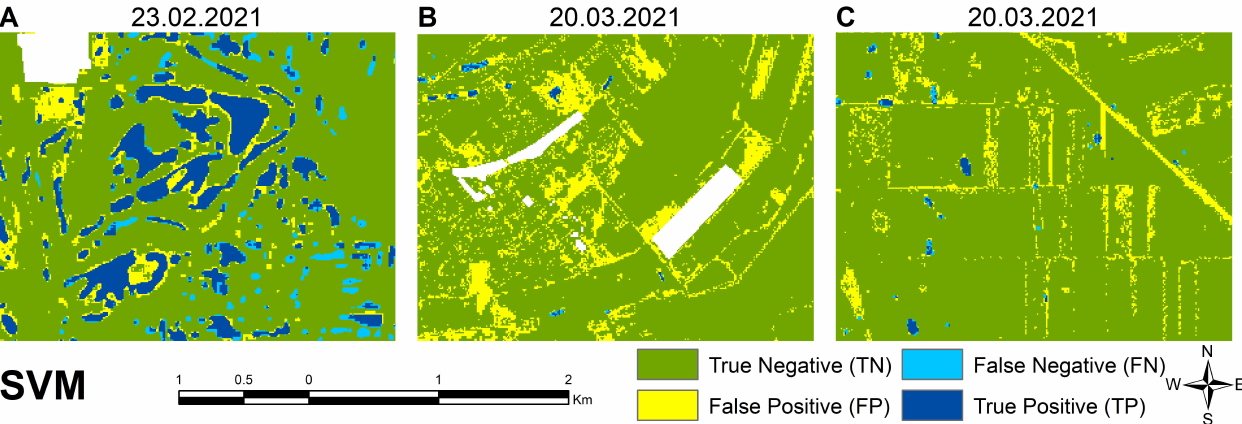
Figure 14. Examples of support ‐ vector machine model classification errors at different times, in ‐ cluding ( A ): Relatively small omissions 23 February 2021; ( B ): extreme overclassification 20 March 2021; ( C ): extreme overclassification 20 March 2021.